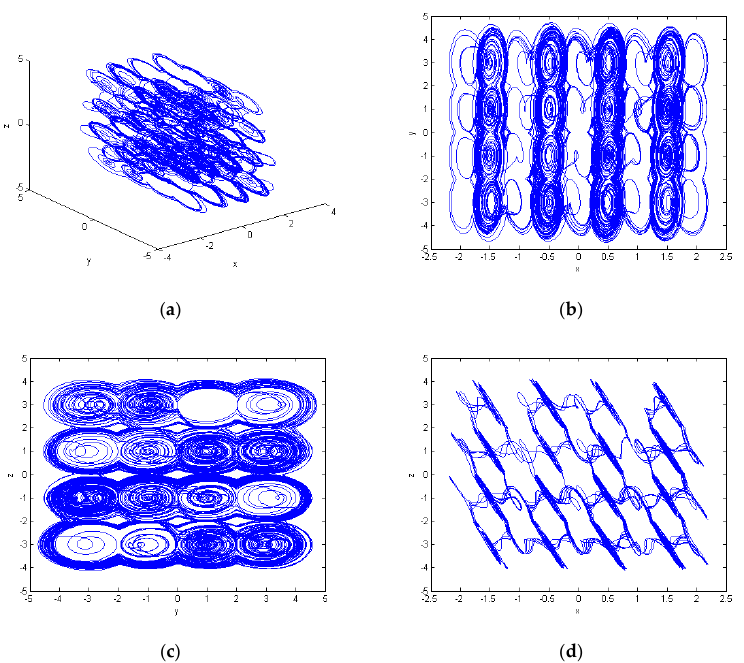
Figure 5. (Color online) 3 × 4 × 4-scroll chaotic attractors of system (2) with n 1 = 0, n 2 = 3, f 1 ( y ) = f 12 ( y ) , f 2 ( z ) = f 22 ( z ) , N 11 = 1, N 22 = 1, and ( x 0 , y 0 , z 0 ) = ( 0.1,0,0 ) : ( a ) x–y–z plane; ( b ) projection on the x–y plane; ( c ) projection on the y–z plane; and ( d ) projection on the x–z plane.